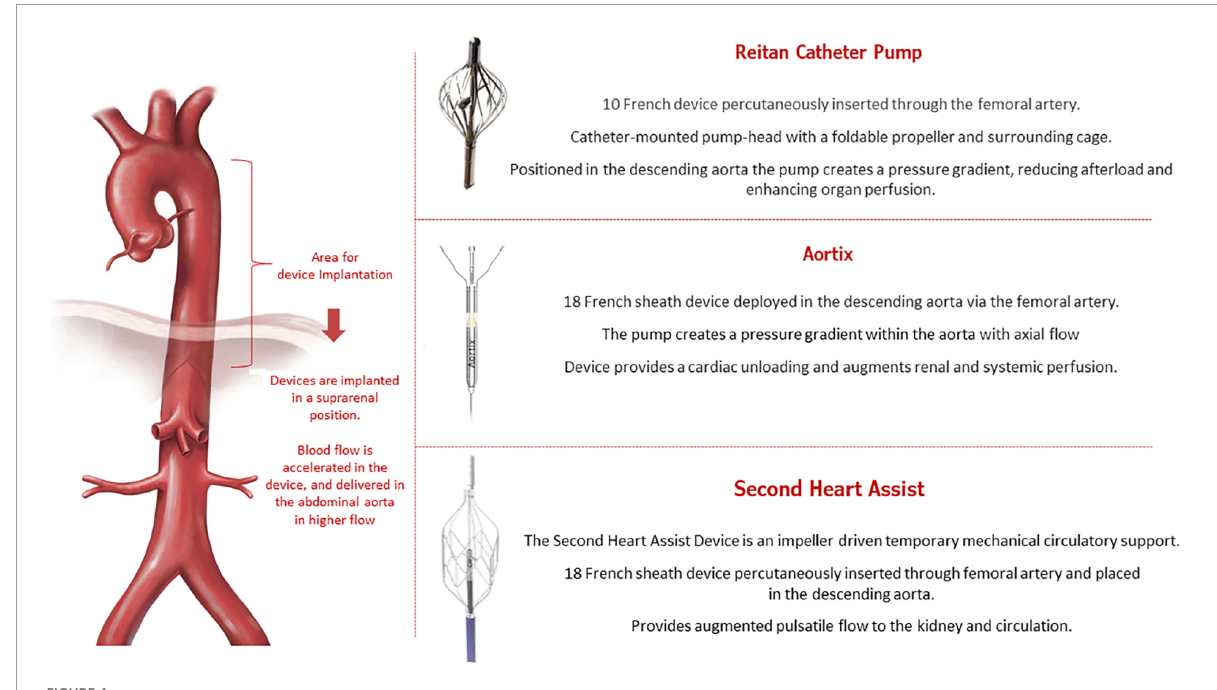
FIGURE4 Pusher devices for heart